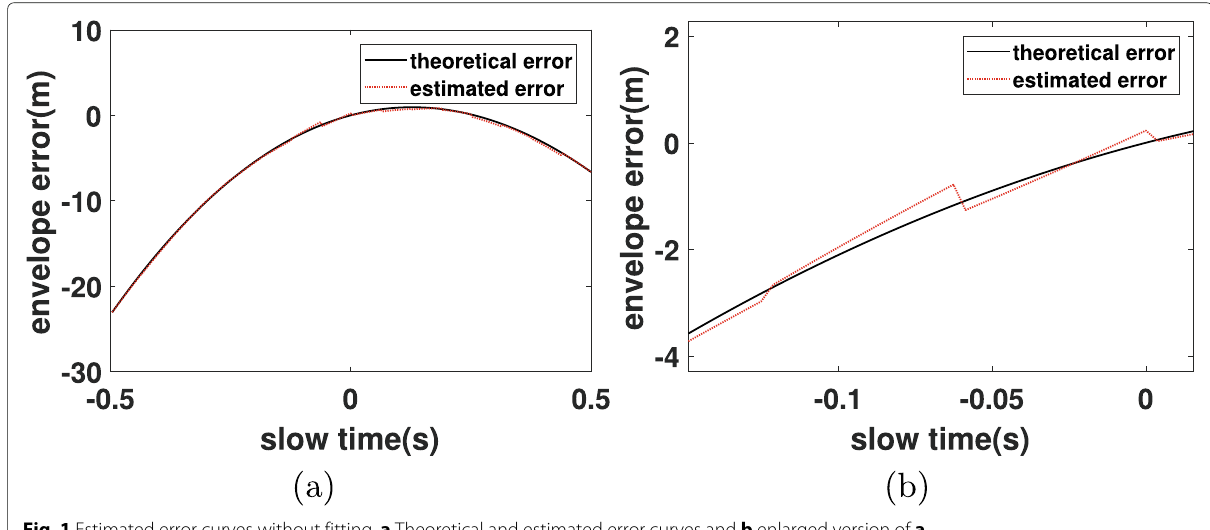
Fig. 1 Estimated error curves without fitting. a Theoretical and estimated error curves and b enlarged version of